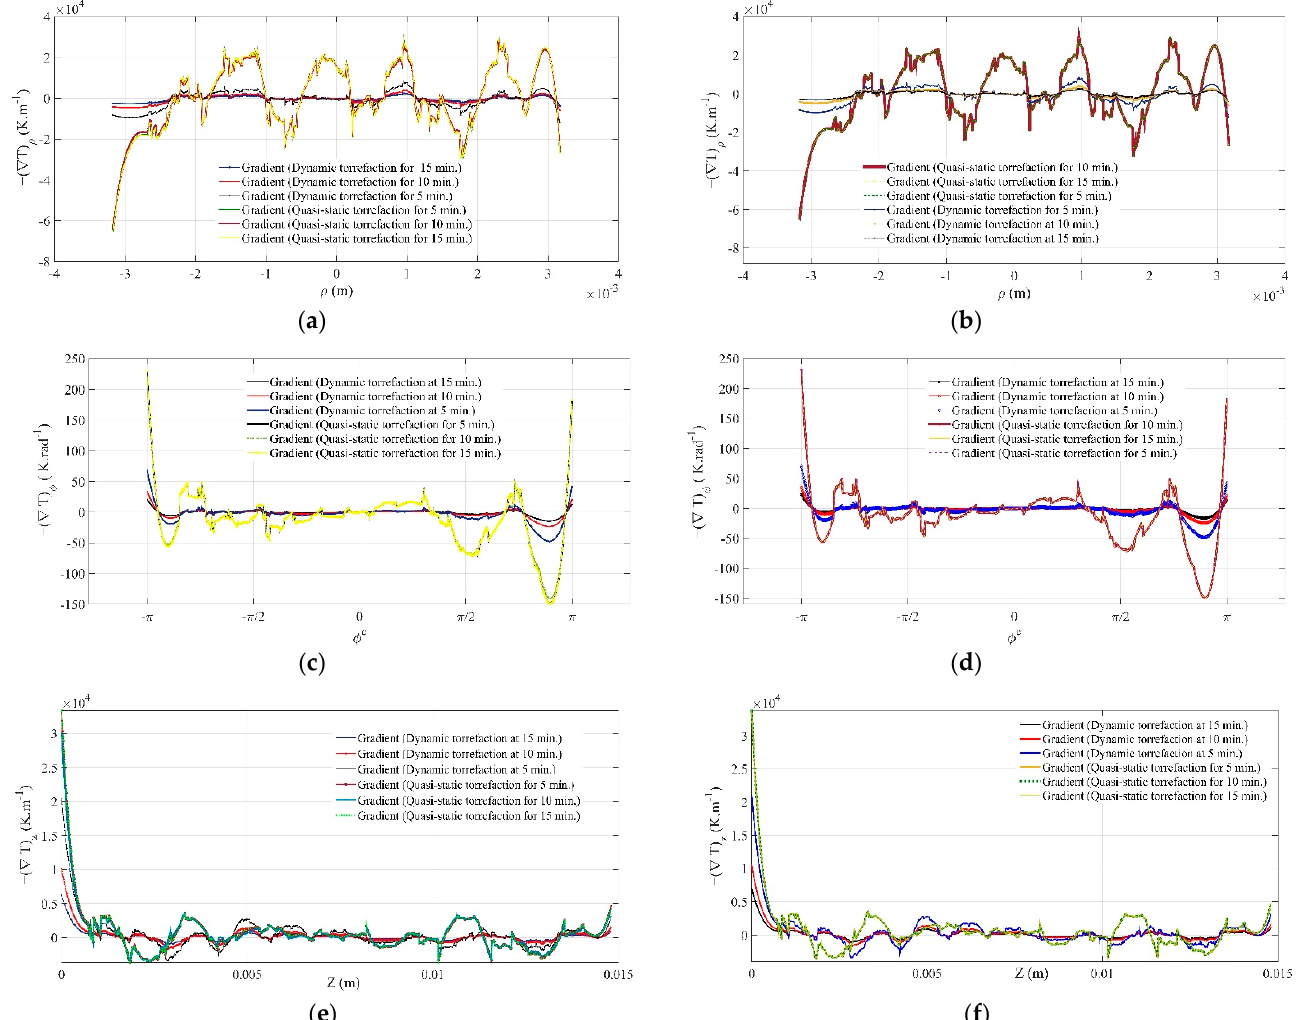
condition is the reverse characteristic. Specifically, the fluctuating heat flux would trans ‐ form into an alternating heat flux, whereas it would have the opposite attribute for dy ‐ namic heating of the system. It was initially elevated when the processing time was in ‐ creased from 5 min to 10 min, and with further increases in the duration of torrefaction, it reversed its path and reduced by 7.1%. However, it would be continuously increasing with the processing time when the pellet is subjected to a time ‐ dependent thermal history. An increase of 39.51% was noticed while increasing the torrefaction time from 10 min to 15 min, whereas it was 52.15% during the initial transition of the system from 5 min to 10 min. Thus, the heat flux gap with the processing time was found to be reduced by 2% and it approached a thermal equilibrium state with increasing processing time. It must be noted that these traits are defined at a particular azimuth plane and would alter with a change in the orientation of the azimuth plane. With the further clockwise rotation of the plane, 𝜙 (cid:3404) (cid:3095) (cid:2870) , the characteristics of thermal gradient or heat flux curves were changed from alternating to fluctuating in nature. The heat flux inside the pellet was increased by 2.5% as the thermal pre ‐ treatment duration changed from 5 min to 10 min, whereas it was no ‐ ticed that it dropped by 2.6% upon further increasing the torrefaction duration in a quasi ‐ static state of the system. Similarly, for the dynamic or time ‐ dependent thermal history, the thermal gradient curves at 𝜙 (cid:3404) (cid:3095) (cid:2870) would share the same characteristic as the quasi ‐ static system but increasing torrefaction time would make the curves asymptotic to the tangential plane to the thermal profile. The relative increase in the heat flux during a pe ‐ riod of 5–10 min would be the same as that estimated at ϕ = 0 for a dynamic condition. This implies that the heat flux or thermal gradient would fluctuate with a constant time ‐ dependent phase difference. If the thermal gradient along the azimuth plane is compared with a thermal gradient along the radial direction, it can be seen that the change in heat flux corresponding to the thermal gradient at a particular spatial position would be far higher in the radial plane than the azimuth plane. It can be concluded that the penetration of the applied heat flux would be much quicker in a thin specimen than in a thick one. On the other hand, the removal of heat in the form of thermal energy would be much higher along an azimuth plane than in the radial direction for a quasi ‐ static system. The opposite is true for a dynamic condition, where the thermal gradient would be much more homog ‐ enous along the radial plane than the azimuth plane and heat would concentrate more in the circumferential region of a pellet. As in the case of the radial plane (Figure 9b), the effect of the steady heat supply (Figure 9d) would be to merely influence the magnitude of the thermal gradient or the corresponding heat flux. It would bear no relationship with the characteristics of the gradient curves.